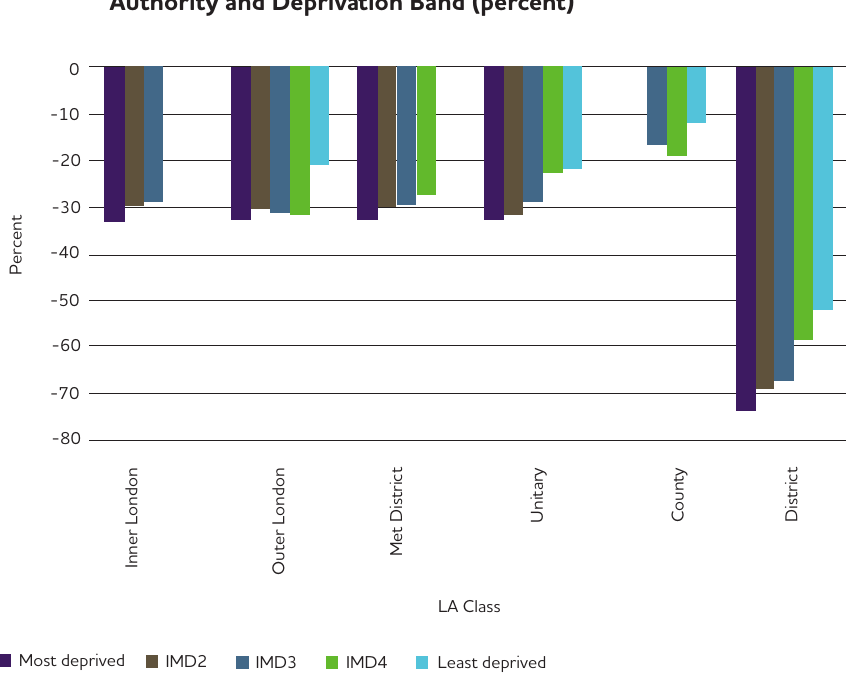
Figure 2: Real change in Spending Power 2010-2015 by Class of Authority and Deprivation Band